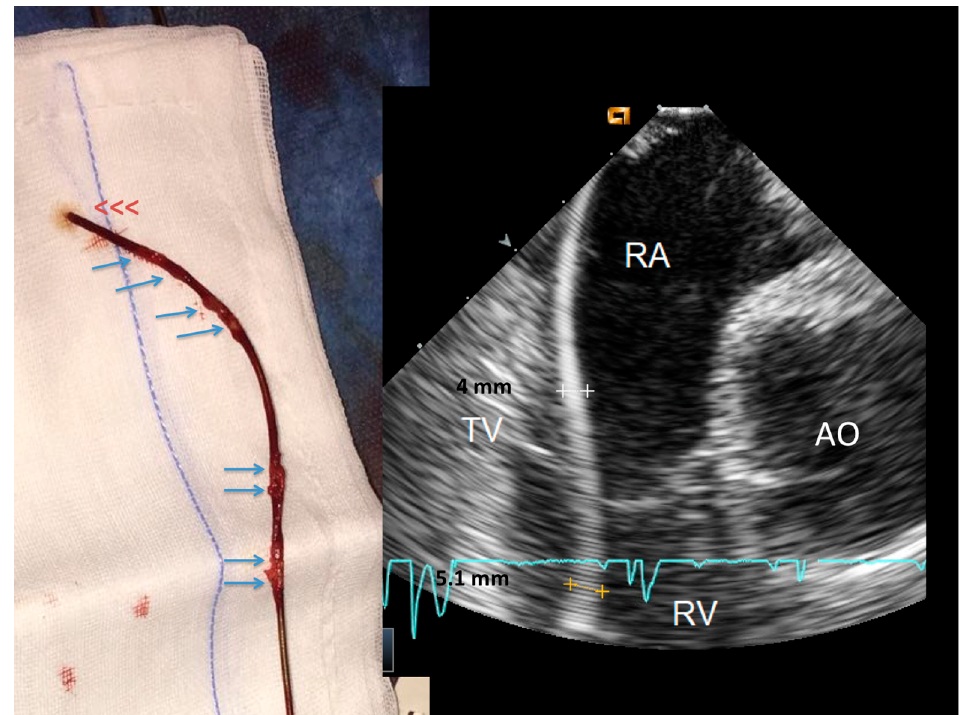
Figure 2. Side-by-side, a thickened lead at ICE and the same lead at visual inspection immediately after extraction. The ventricular lead (right side) is uniformly thickened at ICE. After extraction, the lead (left side) shows remnants of sheathing fibrosis in both the ventricular and atrial parts of the lead (arrows). Abbreviations as in Figure 1.